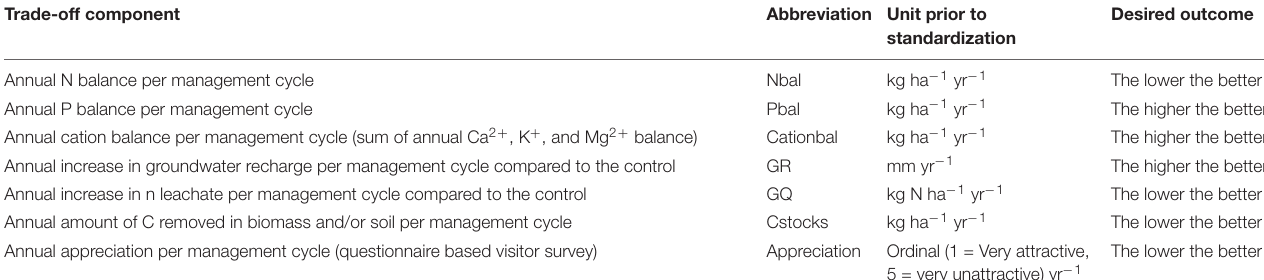
TABLE 2 | Overview of trade-off components prior to standardization and their desired outcome.